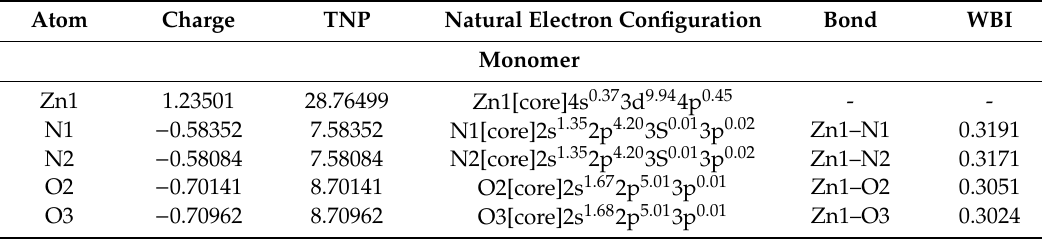
Table 3. The natural atomic charges (NACs), total natural populations (TNPs), natural electronic configurations (NECs), and Wiberg bond indices (WBIs) of selected atoms in the [Zn(sal)](H 2 O) complex, as calculated at the B97D / cc-pVTZ level of